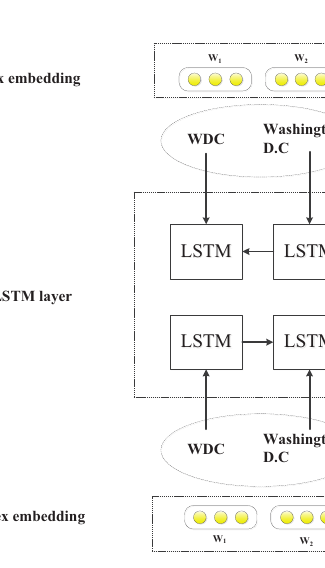
Figure 4. A sketch of the BiLSTM-based hyperlink direction prediction model, the entities in the directed hyperlink are divided into head and tail parts according to the label and are input into the BiLSTM layer in a specific order. The hyperlink representation is obtained by splicing the representation vectors obtained from each direction of the BiLSTM layer. Finally, the direction score is obtained through a Softmax